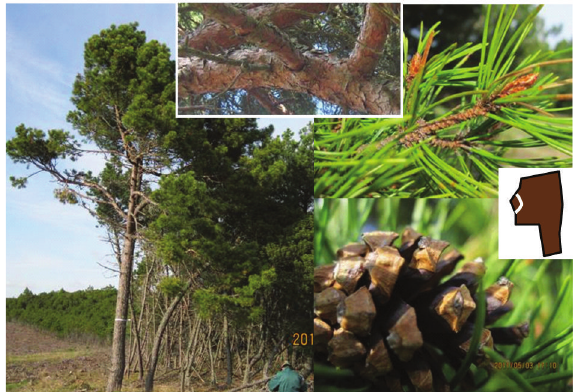
Figure 4: Putative P. mugo (female) × P. sylvestris (male) hybrid (H S × M, group B in Figure 5, Table 2, ID PD56). Left, monocormic, needles fresh green ( mugo , note pure P. mugo trees in the background and to the right with the same fresh green needle colour), upper stem with dark brown flakes ( sylvestris ), no paper flakes ( mugo ); upper right: shoots dark green brown glossy ( mugo ), needles fresh green ( mugo ), stem unit tip does not bend backwards at the needle sack (sylvestris); lower right: cone apophysis glossy ( mugo ) medium-thick hook (intermediate), umbo bordered ( mugo ), rather symmetric ( sylvestris ).